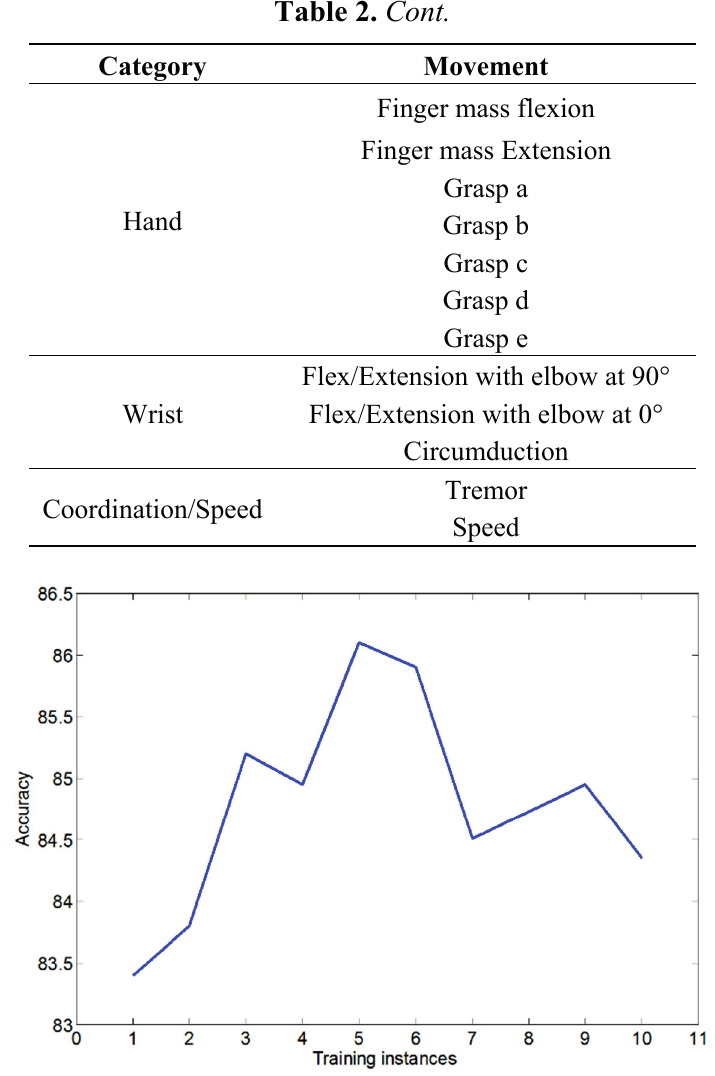
Figure 7. The accuracy of our classifiers given the number of training